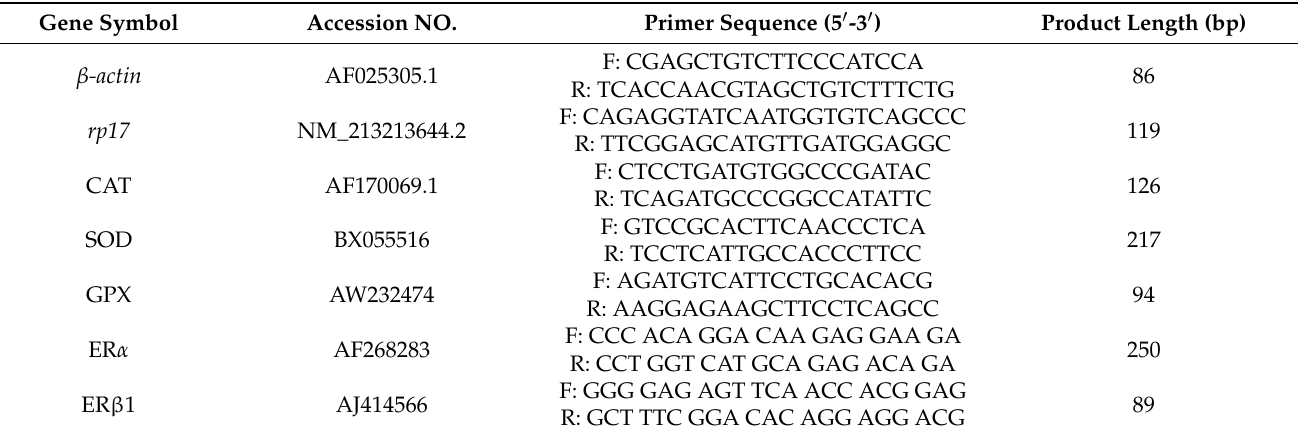
Table 1. Primer sequences of candidate reference